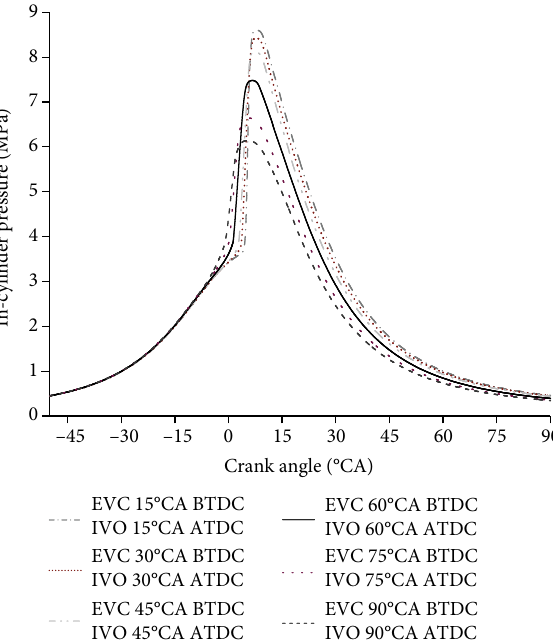
Figure 21: In fl uence of symmetric NVO on pressure.